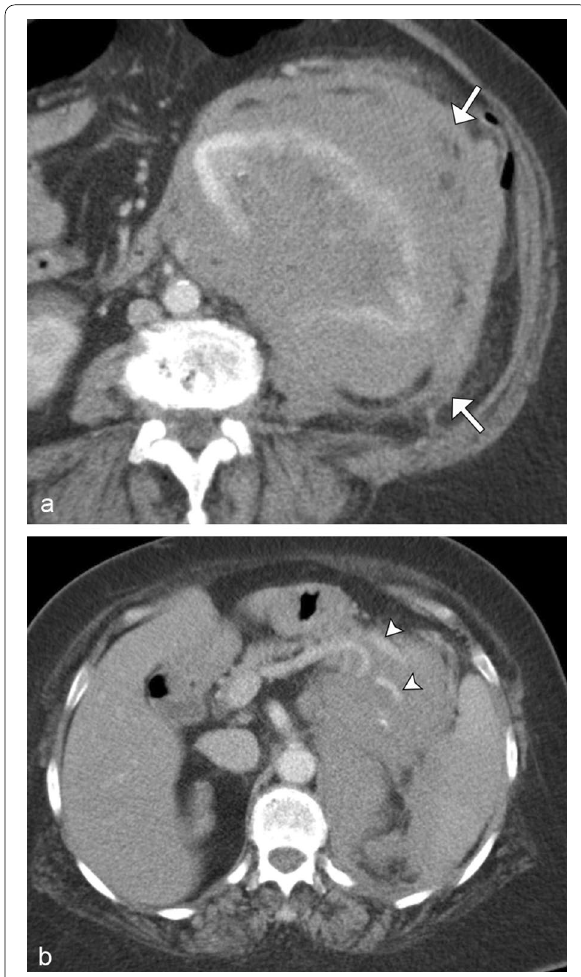
Fig. 8 Perinephric space infiltration of renal lymphoma . Axial CT of the abdomen ( a ) demonstrates an infiltrative homogenous mass (arrows) in the left retroperitoneum enveloping the left kidney with preservation of the left renal parenchymal anatomy. Additional thickening of Gerota’s fascia and Zuckerkandl fascia as well as retroperitoneal tumor infiltration along the pancreatic tail and splenic hilum are present ( b ). Note the preservation of normal caliber splenic vein and artery (arrowheads). Due to the unusual tumor morphology, the left renal mass was biopsied and consistent with diffuse large B-cell